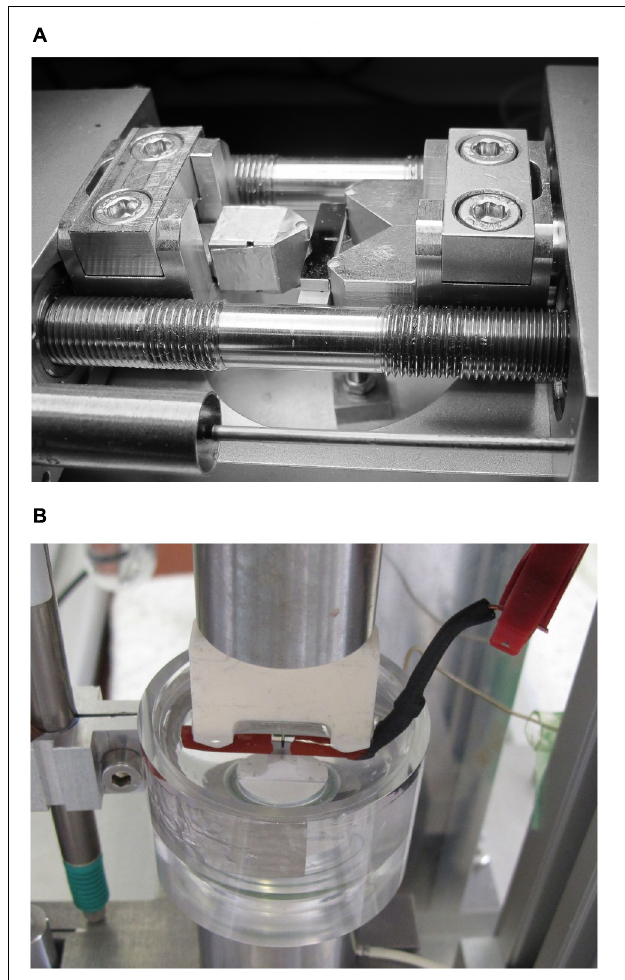
FIGURE 1 | (A) Three-point-bending (3PB) test in air with notched Vit 105 bulk metallic glass (BMG) sample in a Kammrath &Weiss tensile-compressive testing device with 3PB kit and (B) setup for 3PB-stress corrosion cracking (SCC) testing in 0.01 M NaCl with notched Vit 105 BMG sample, Pt counter, and SCE reference electrodes in an electrolyte